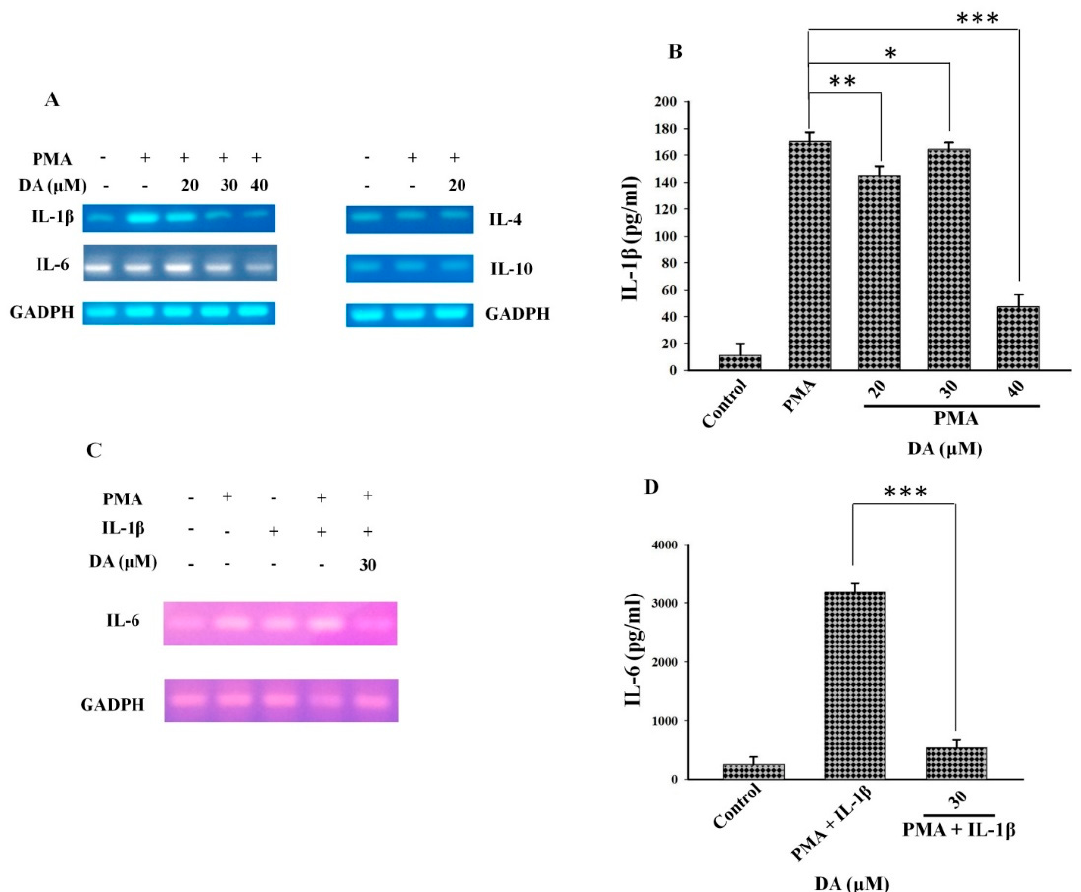
Figure 1. DA inhibits PMA-induced production of proinflammatory cytokines. ( A ) total RNA was extracted from the treated HL-60 cells using TRIZOL reagent and was reverse-transcribed into cDNA. The amplified products were analyzed through electrophoresis on a 1% agarose gel and visualized using an EcoDye™ Nucleic Acid Staining Solution. Images were then captured using Wise Capture I-1000 software (Daihan Scientific, Seoul, South Korea). DA inhibited pro-inflammatory cytokines in PMA-induced macrophages; ( B ) IL-1 β exogenous secretion was measured through ELISA. A 96-well plate was coated with 10 µ g/mL purified goat anti-IL-1 β antibody. Cell culture supernatants from the control and treated groups were incubated in these plates for 1 h, and then a polyclonal rabbit anti-IL-1 β antibody was added to the wells. HRP-conjugated goat anti-rabbit IgG was then added, and the cells were incubated for 30 min. ABTS solution was then added to the plate, and the signal that was developed was detected using a reference wavelength of 490 nm. Data are given as the mean ± SD. * p < 0.05, ** p < 0.01, *** p < 0.001; ( C ) cells were treated with PMA overnight and then incubated with